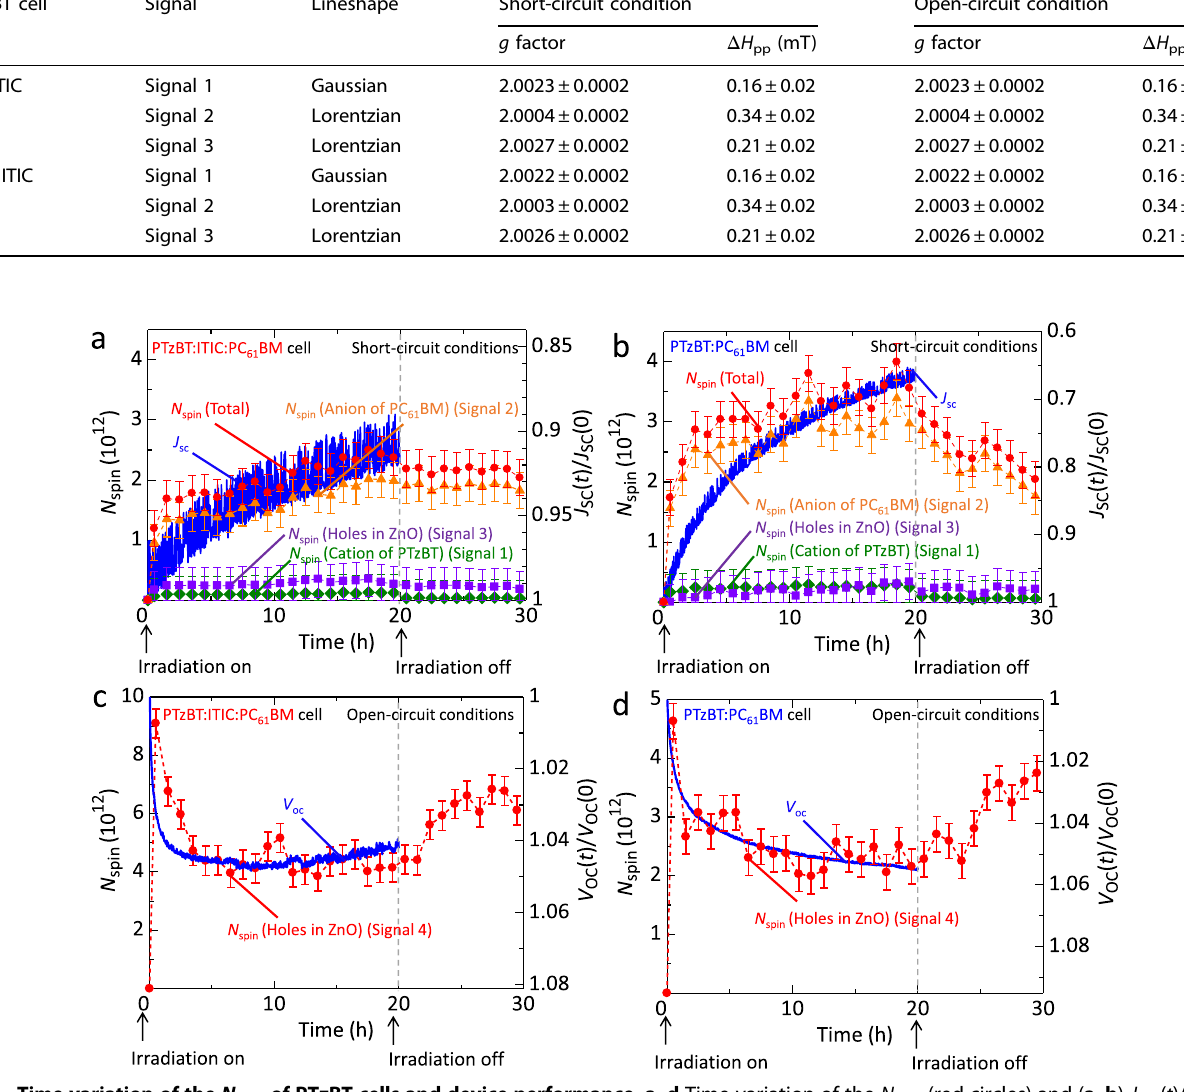
Fig. 7 Time variation of the N spin of PTzBT cells and device performance. a – d Time variation of the N spin (red circles) and ( a , b ) J SC ( t )/ J SC (0) (blue line) or ( c , d ) V OC ( t )/ V OC (0) (blue line) for the cells ( a , c ) with and ( b , d ) without ITIC under solar irradiation at room temperature, respectively. Here, J SC ( t ) and V OC ( t ) are normalized to their initial values of J SC (0) and V OC (0) at irradiation time t = 0, respectively. The N spin are plotted at each averaged time over 1 h. The error bars in a , b , d and in c are ±0.3 × 10 12 and ±0.5 × 10 12 , respectively.